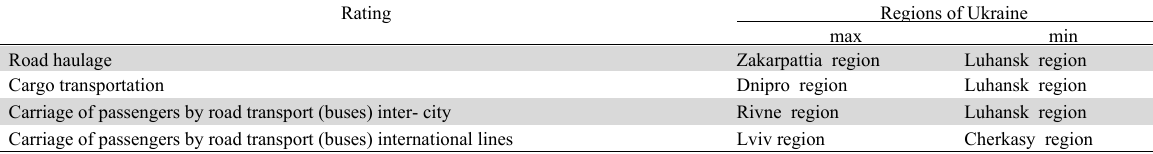
Rating Regions of Ukraine